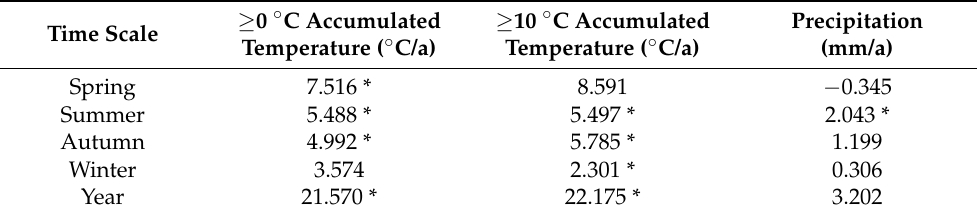
Table 1. The variation trends and significance of water and thermal elements in Henan Province from 1978–2021 under different time scales. The * represents passing the 0.05 significance